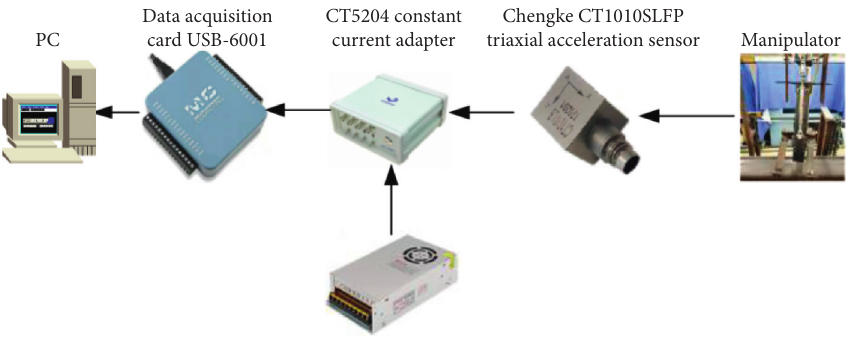
Figure 12: Accelerometer and signal conditioning